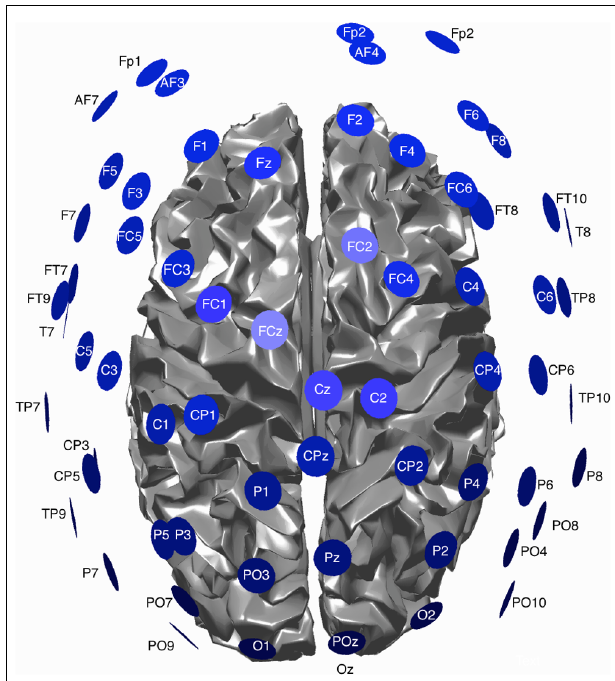
FIGURE 1 | Schematic view of the EEG montage and cortical surface used for EEG data acquisition.